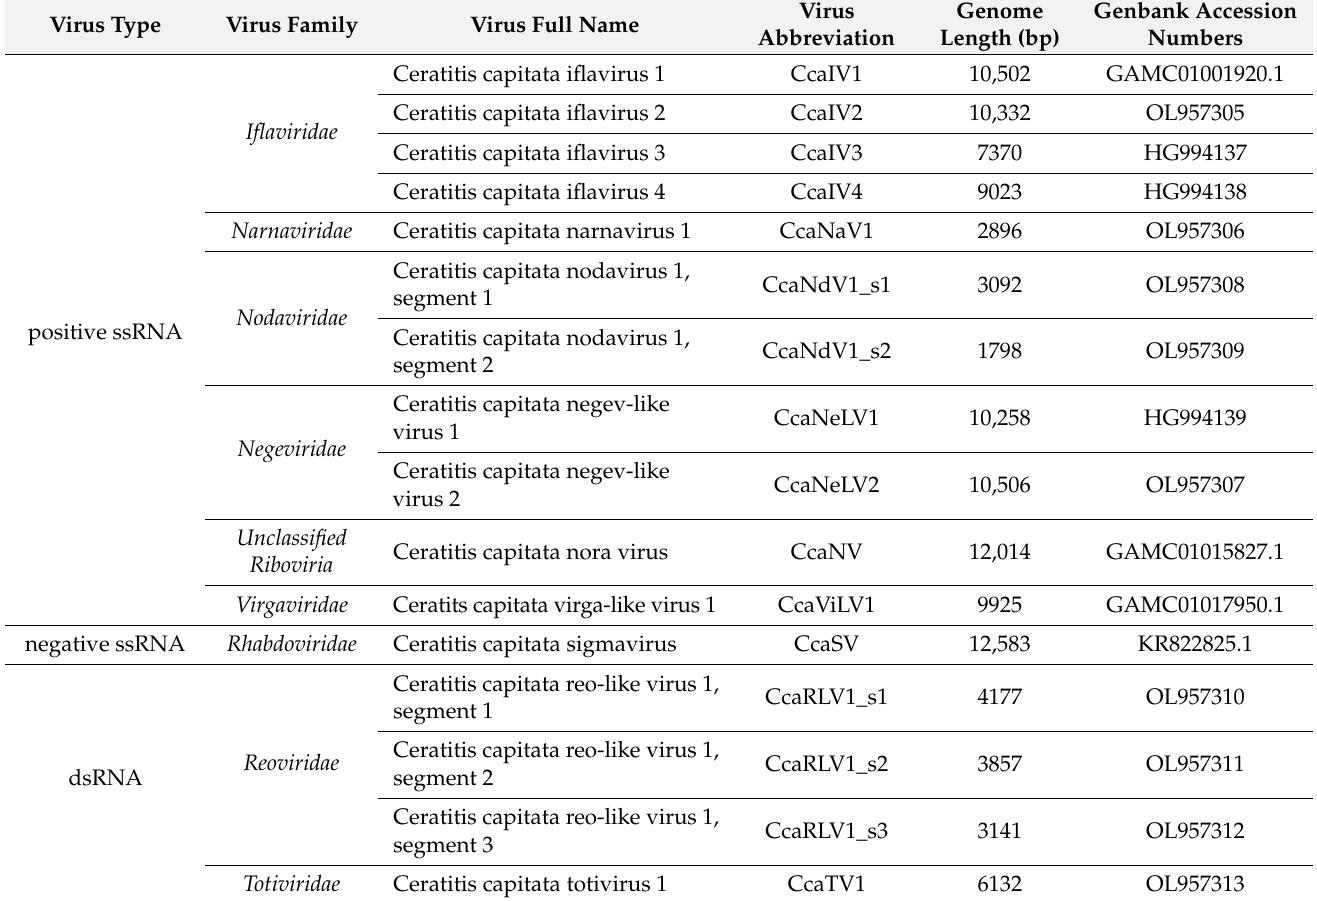
Table 1. List of the 13 RNA viruses described for